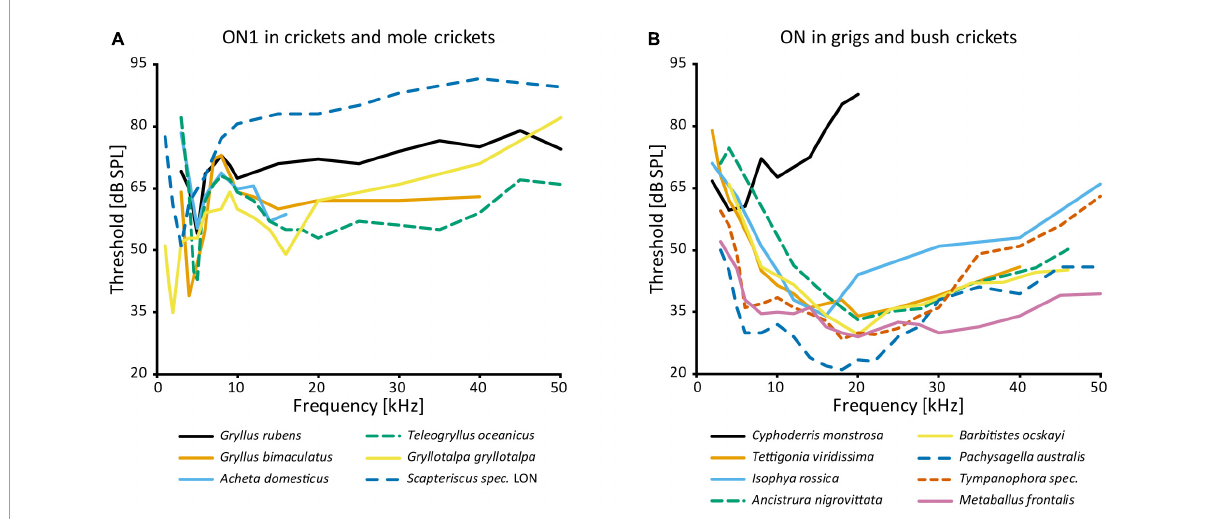
FIGURE3 Frequency tuning of ON(1): (A) threshold curves of ON1 in crickets and mole crickets. Source of data: G. rubens : Farris et al., 2004, G. bimaculatus : Watson and Hardt, 1996; A. domesticus : Stumpner et al., 1995; T. oceanicus : Atkins and Pollack, 1986; G. gryllotalpa : Zhantiev and Korsunovskaya, 1990a; Scapteriscus spec.: Mason et al., 1998. (B) Threshold curves of the omega neuron in grigs and bush crickets. Source of data: A. nigrovittata and B. ocskayi : Stumpner, 2002; C. monstrosa : Mason and Schildberger, 1993; I. rossica : Korsunovskaya and Zhantiev, 1992; Pachysagella australis , Metaballus frontalis, and Tympanophora spec.: Römer et al., 1989; Tettigonia viridissima : Römer,